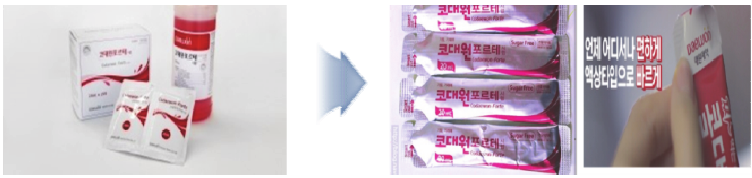
<Figure 5> Pharmaceutical packaging with Stick-typed Spout